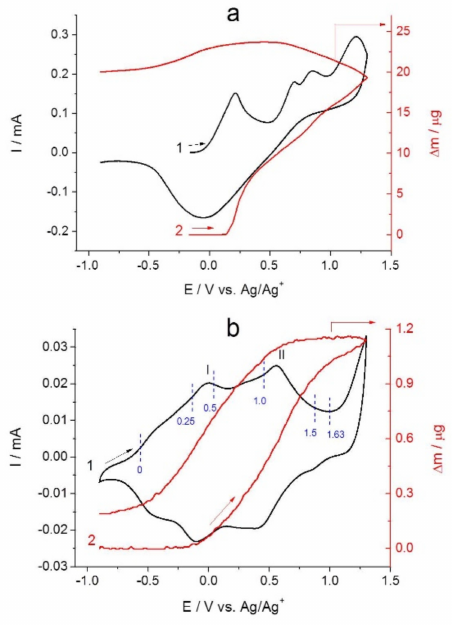
Figure 6. ( a ) Cyclic voltammogram showing electropolymerization of [NiAmben] (0.001 mol L − 1 ) at a Pt-coated quartz crystal electrode (1.37 cm 2 ) at a scan rate of 0.05 V s − 1 (black curve 1) and corresponding electrode mass variation with potential (red curve 2); ( b ) CV curve of poly-[NiAmben] at 0.01 V s − 1 (black curve 1) and corresponding change in electrode mass (red curve 2); blue numbers show oxidation states of the polymer. Electrolyte: 0.05 M Et 4 NBF 4